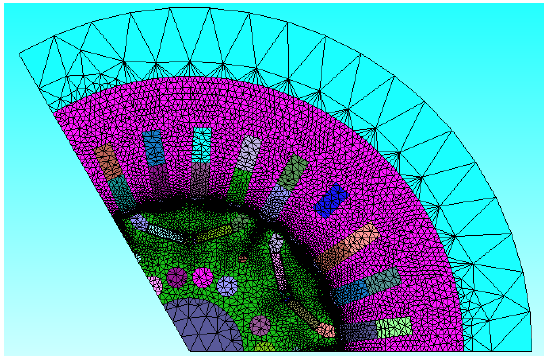
Figure 9. The finite elements method (FEM) model of 322 kW IPMSM considered in this paper.